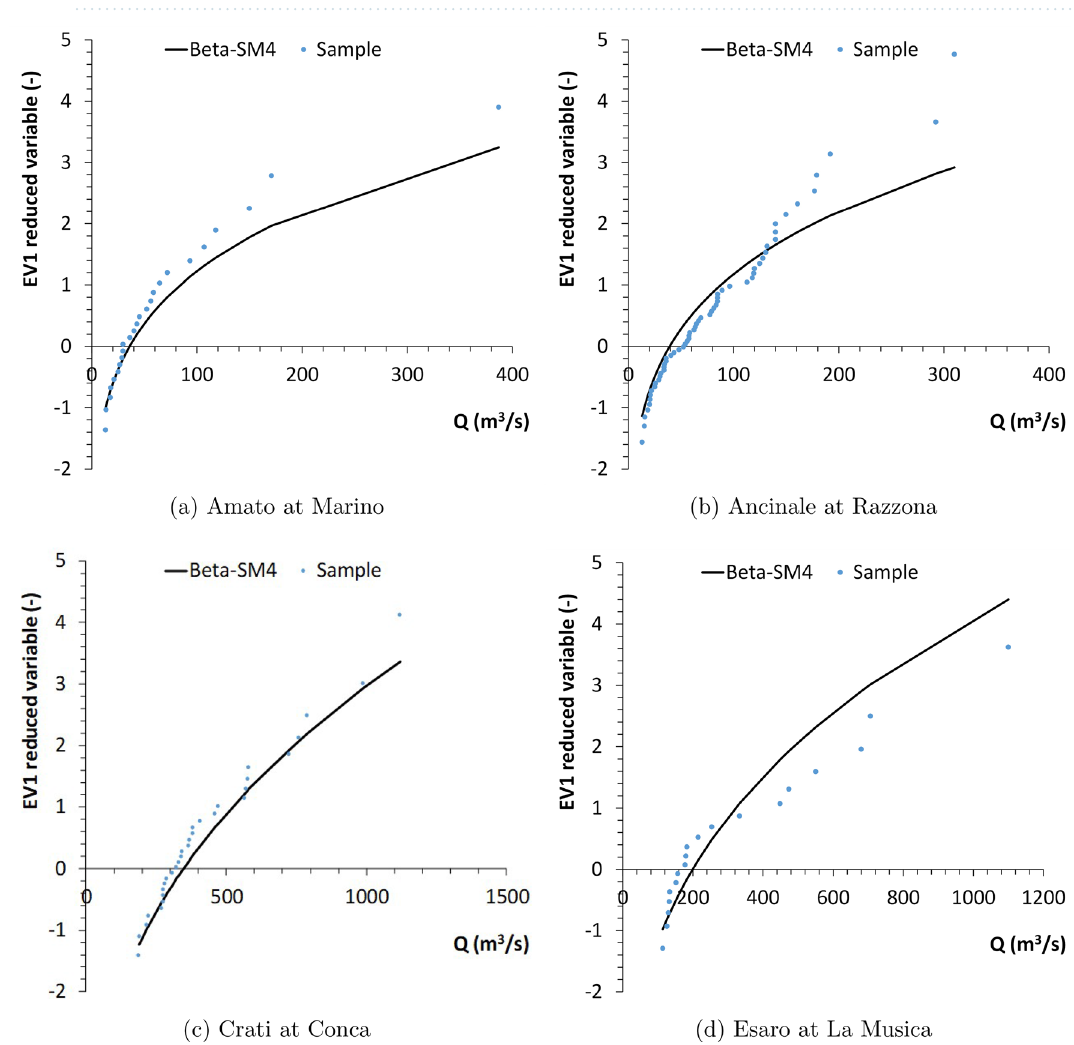
Figure 6. EV1 probabilistic plot of Beta-SM4 for some